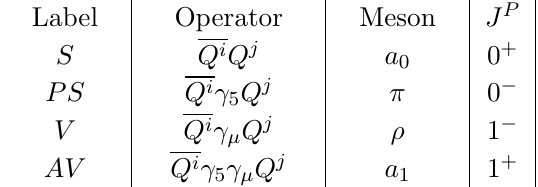
Figure 1 . The moose diagram representing the EFT description of the vector mesons in the model. Label Operator